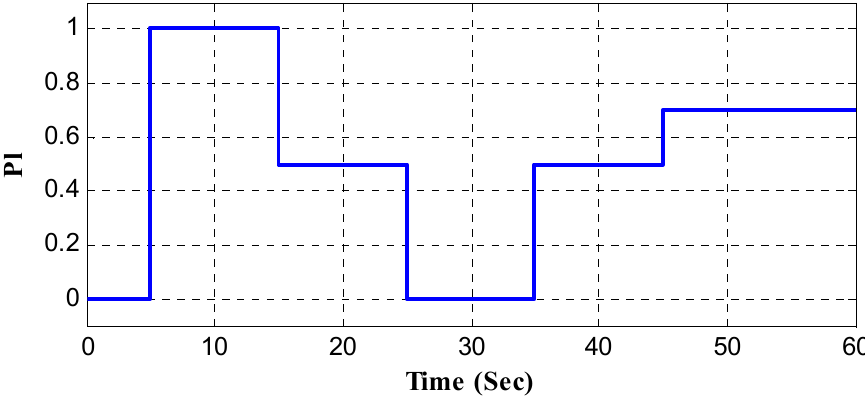
Figure 34. Implemented varying load disturbance (PL).